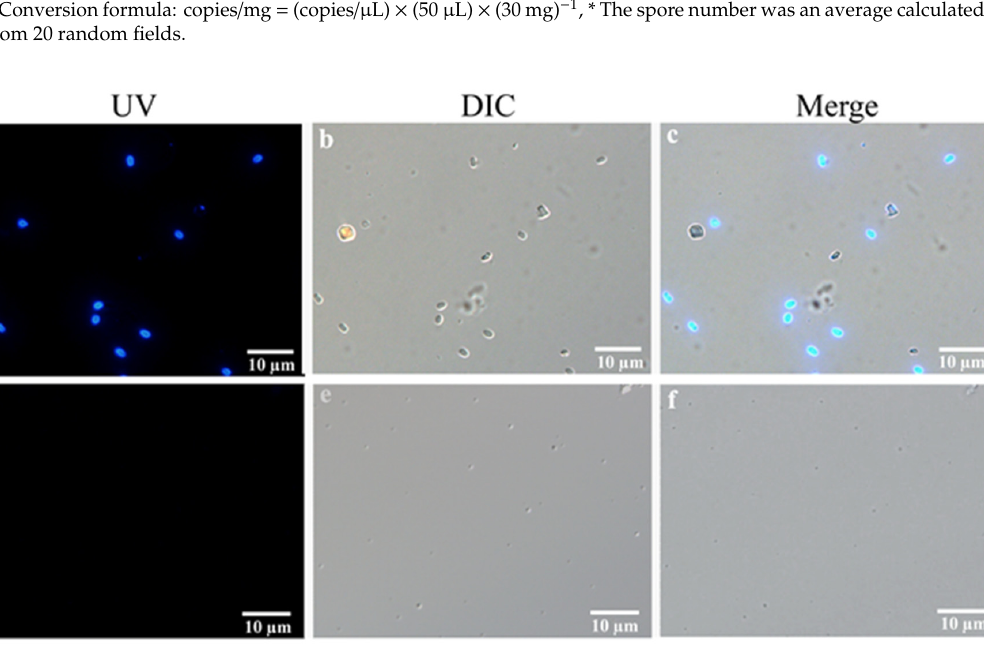
Figure 4. Staining analysis of EHP spores in the hepatopancreas of shrimp samples. ( a – c ) The hepatopancreas of EHP-infected shrimp samples staining with Fluorescent Brightener 28 on the UV light phase, differential interference contrast (DIC) phase, and a merged image. ( d – f ) The hepatopancreas of normal shrimp samples staining with Fluorescent Brightener 28 on the UV light phase, differential interference contrast (DIC) phase, and a merged image. Bar, 10 µm. Table 4. Integrated analysis of microscopy and PTP2-qPCR for EHP quantification.